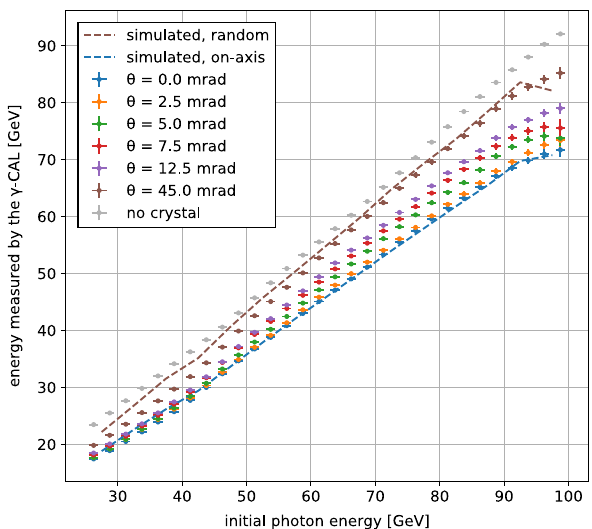
Fig. 2 Energy measured by γ -CAL as a function of the tagged photon energy, at different angles between the beam and the (cid:2) 111 (cid:3) axis and in the random orientation (45 mrad). Background data, i.e., with no crystal along the photon path, are also shown. The points (dashed lines) represent the experimental data (simulated